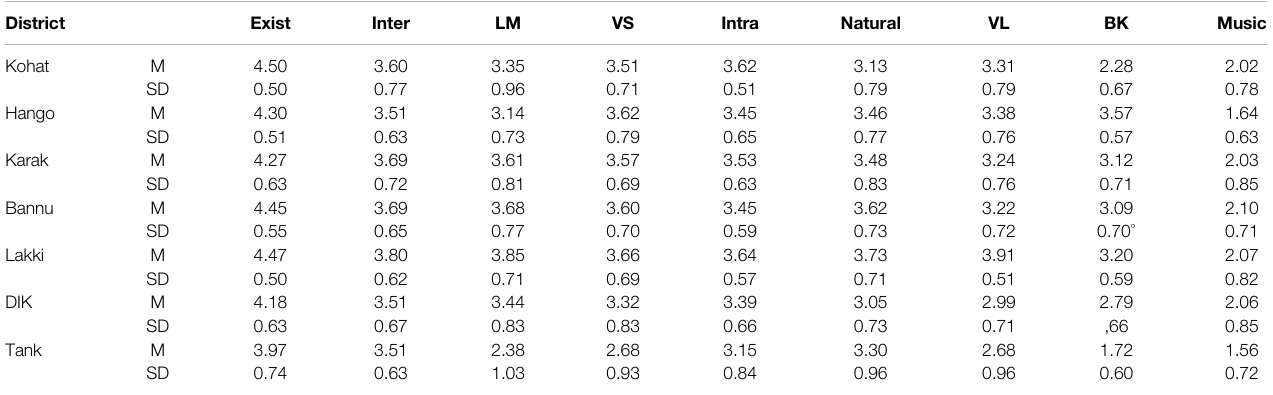
TABLE 1 | Mean and SD of students ’ multiple intelligences ( N (cid:1) 905). District